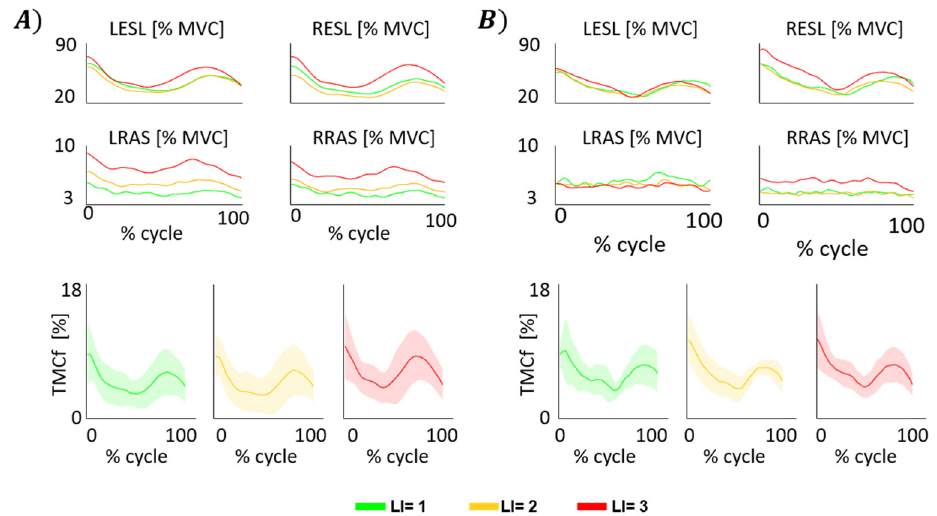
Figure 2. Mean envelopes among all subjects for each lifting condition of the left (LESL) and right (RESL) erector spinae longissimus and the left (LRAS) and right (RRAS) rectus abdominis, considering all the cycles of the task and mean envelopes ( ± SD) among all subjects for each lifting condition of TMCf function in both groups: healthy controls ( A ) and people with Low Back Pain ( B ). LI: Lifting index.